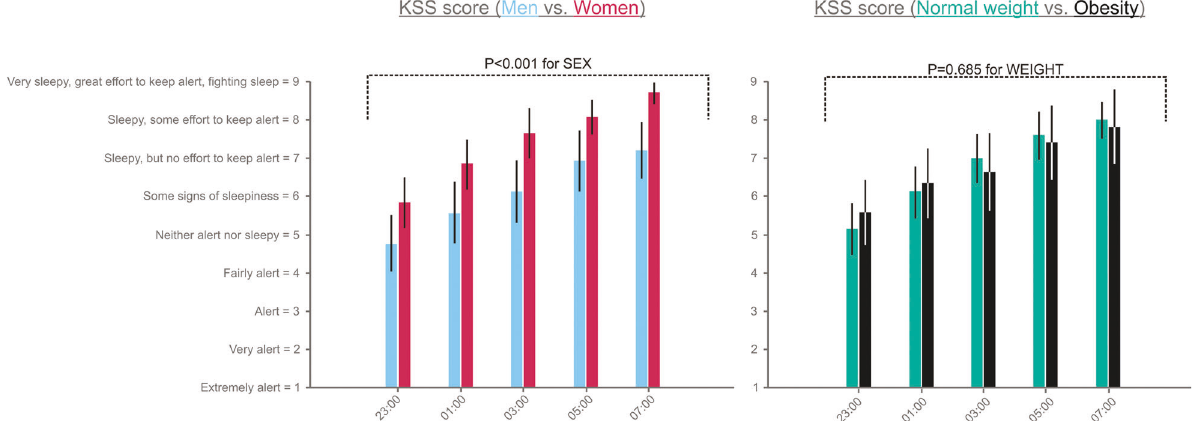
Fig. 2 Subjective sleepiness during the sleep loss night. Values are shown as estimated marginal means [95%-CI] as derived from generalized linear mixed models. Baseline (i.e., at 23:00) Karolinska Sleepiness Scale (KSS) scores (mean ± SD): men, 4.8 ± 1.9; women: 5.7 ± 1.5; with normal weight: 5.1 ± 1.6; and with obesity: 5.4 ± 1.9. P < 0.05 was considered signi fi